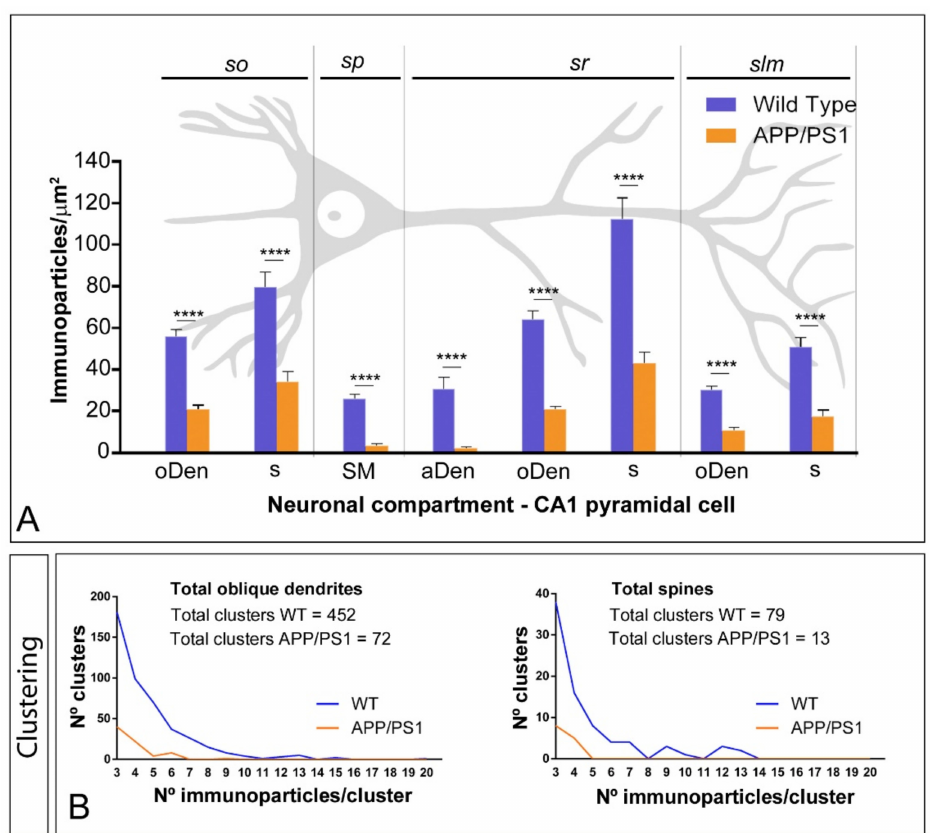
Figure 3. Quantitative analysis of mGlu 5 immunoparticles along the surface of CA1 pyramidal cells . ( A ) Density gradient of mGlu 5 immunogold labelling in eight neuronal compartments of CA1 pyramidal cells in wild type and APP/PS1 mice at 12 months. The density gradient of surface mGlu 5 immunoparticles was significantly reduced in the APP/PS1 mice compared to age-matched wild type controls in all strata and subcellular compartments analysed (Two-way ANOVA test and Bonferroni post hoc test, **** p < 0.0001) (Table 1). Error bars indicate SEM. Abbreviations: so , stratum oriens ; sp , stratum pyramidale ; sr , stratum radiatum ; slm , stratum lacunosum-moleculare ; aDen, apical dendrite; oDen, oblique dendrite; s, spine; SM, soma. ( B ) Histograms showing composition of clusters in all oblique dendrites and all spines of CA1 pyramidal cells. For all of the oblique dendrites analysed, the number and size of clusters of mGlu 5 immunoparticles was reduced in the APP/PS1 mice (72 clusters with a range of 3 to 9 immunoparticles in oblique dendrites; 13 clusters with a range of 3 to 4 immunoparticles in spines) compared to age-matched wild type controls (452 clusters with a range of 3 to 20 immunoparticles in oblique dendrites; 79 clusters with a range of 3 to 13 immunoparticles in